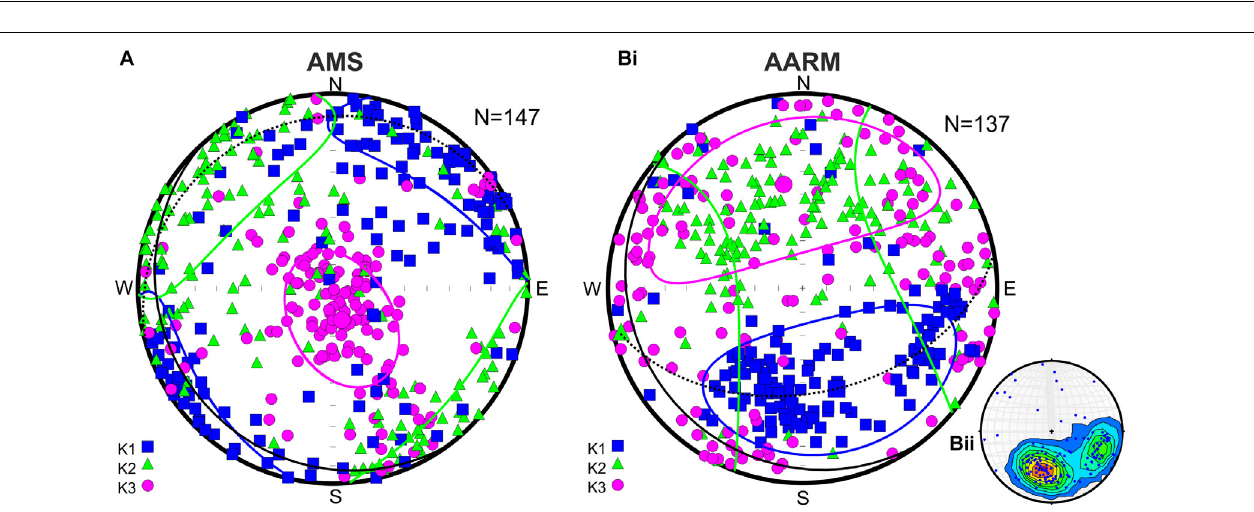
FIGURE 5 | Equal area plots of data from all specimens for both (A) AMS data ( N = 147) and (B) AARM data ( N = 137) with (Bi) representing data for all axes and (Bii) showing a contour plot of K 1 axes. K 1 axes are blue squares, K 2 axes are green triangles and K 3 axes are purple circles. Solid lines are the 95% confidence ellipses calculated by Anisoft 4.2. Solid black line represents the sill plane and the dashed black line represents the magnetic foliation plane.